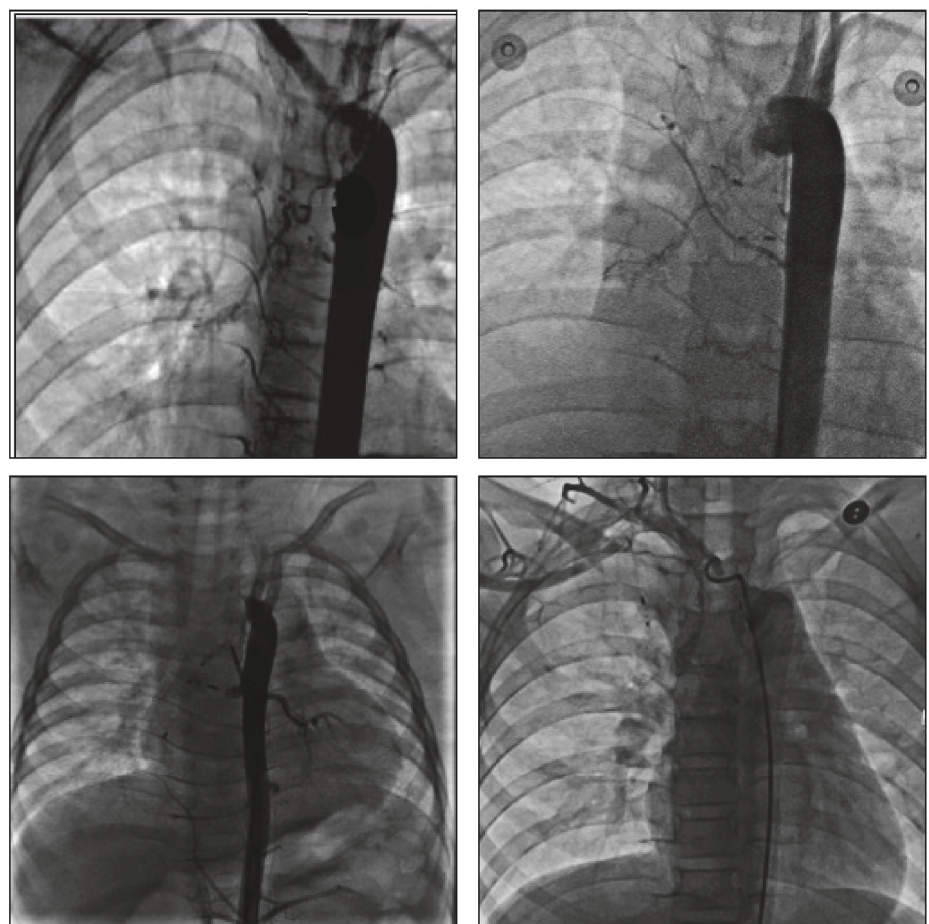
Figure 3: A secondary DSA of recurrent cases that had undergone transcatheter occlusion. 3A: a targeted abnormal BA that originated from the aortic arch was detected, which led to recurrence; 3B: two BAs from the thoracic trunk were blocked off, and a tortuous artery was clearly displayed from the aortic arch; 3C: after transcatheter occlusion of the dilated BAs from the thoracic aorta, another abnormal BA from the abdominal BA was detected in a secondary DSA presentation,which led to a recurrence;3D: a recurrentcase of an abnormal BA was detected with a tortuous route and abnormal origin from the right subclavian